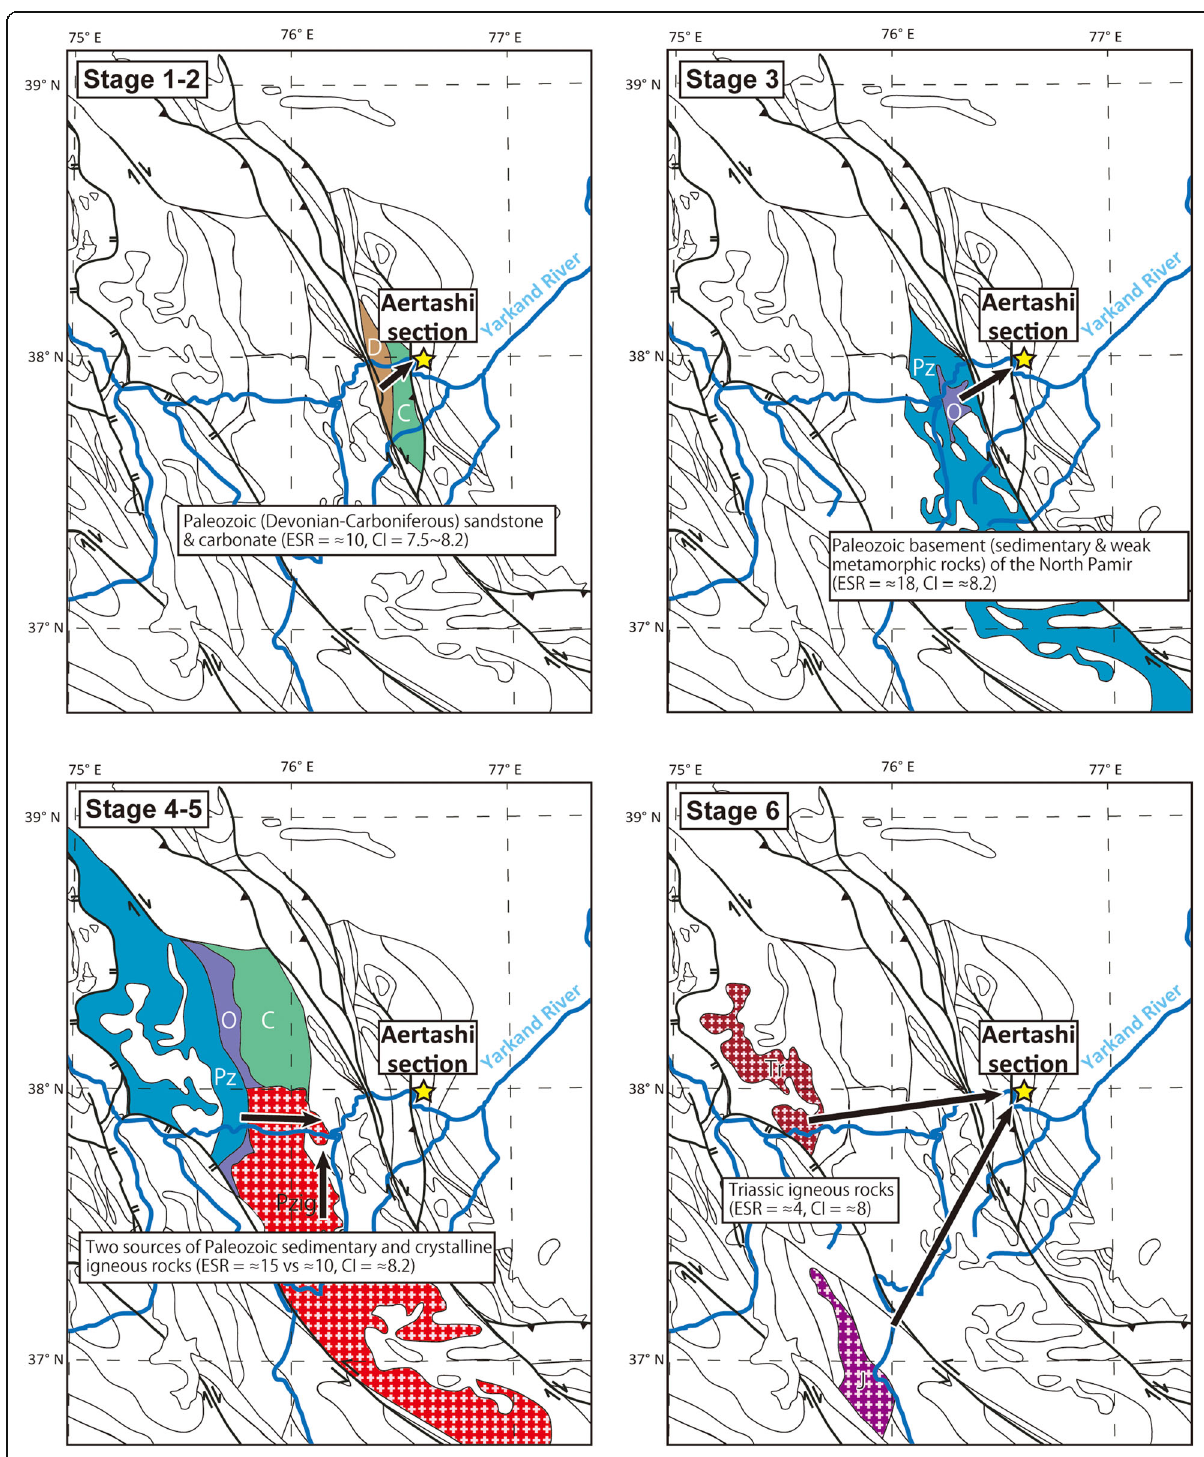
Fig. 9 Acquired drainage of the paleo-Yarkand River during each